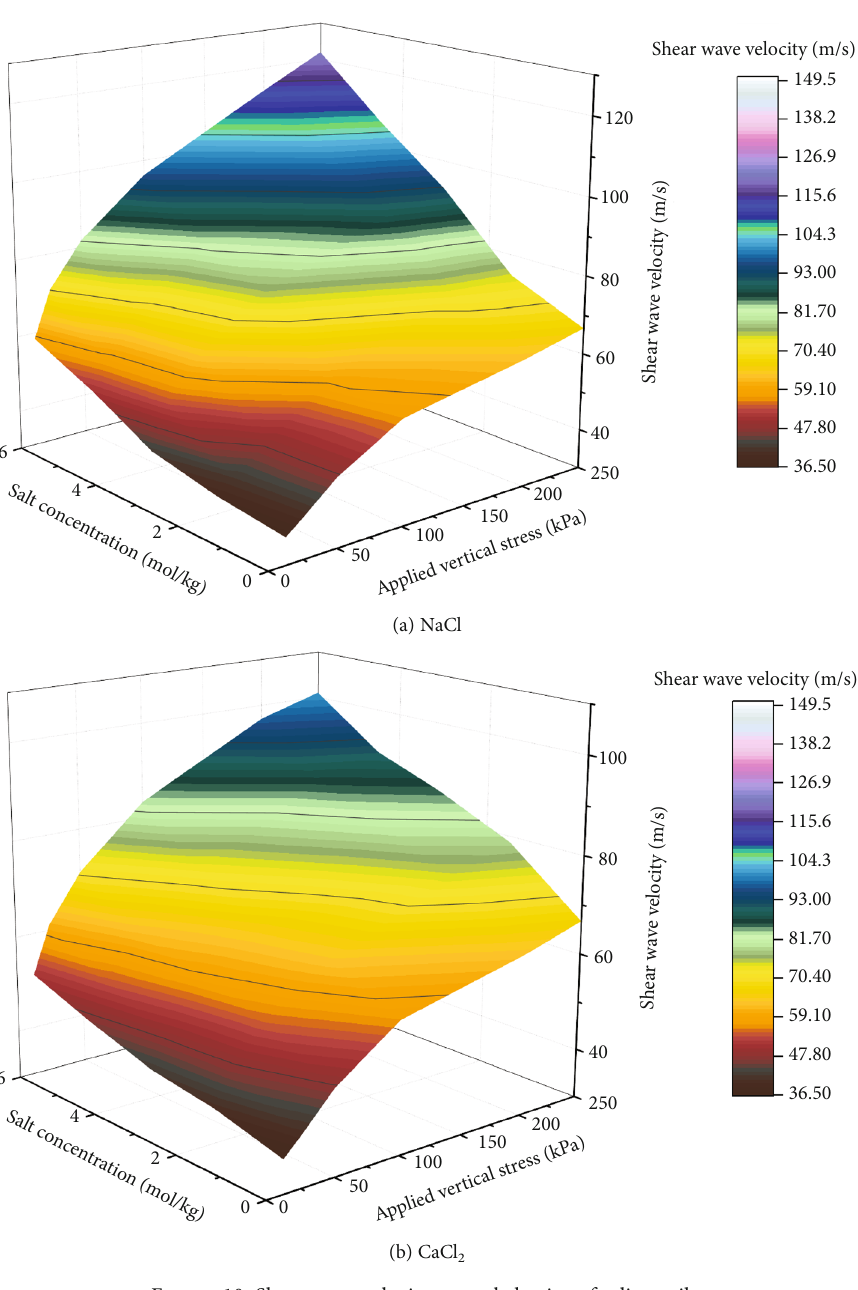
Figure 10: Shear wave velocity-stress behavior of saline